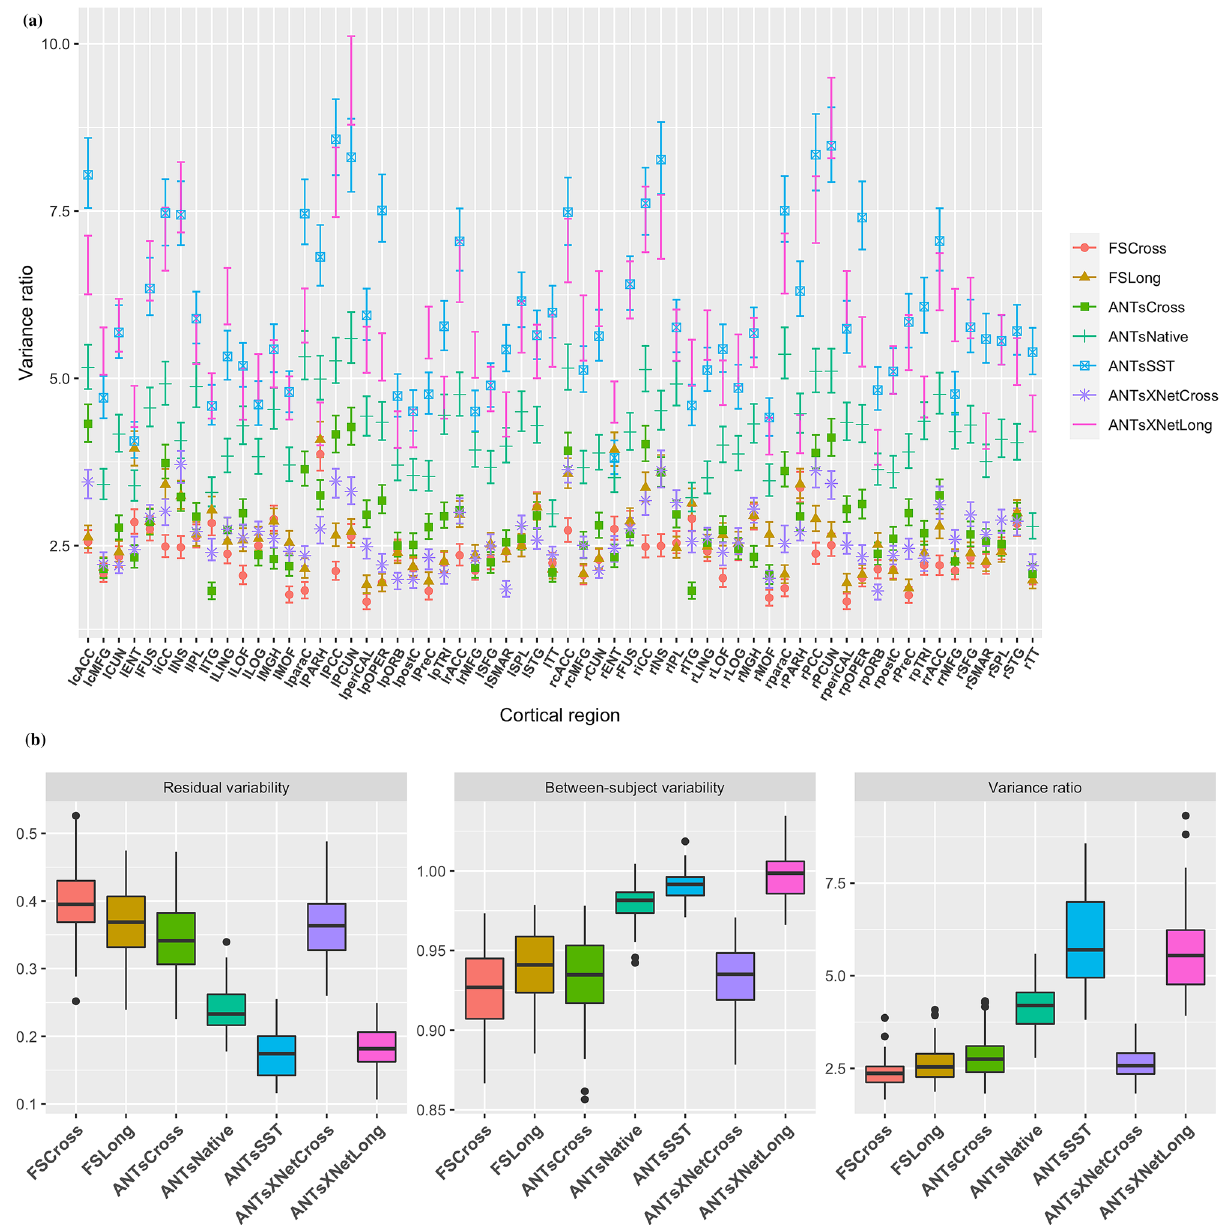
Figure 5. Performance over longitudinal data as determined by the variance ratio. ( a ) Region-specific 95% confidence intervals of the variance ratio showing the superior performance of the longitudinally tailored ANTsX-based pipelines, including ANTsSST and ANTsXNetLong. ( b ) Residual variability, between subject, and variance ratio values per pipeline over all DKT